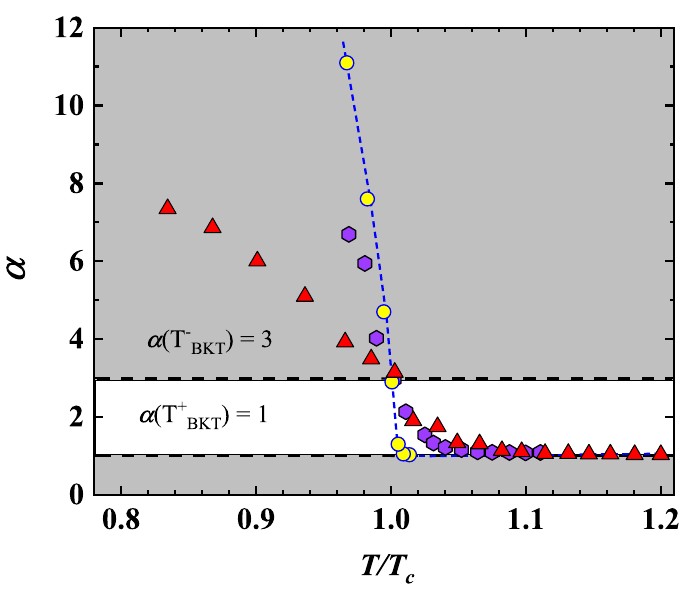
Figure 8. Temperature − dependence of α for MO10 (yellow circle), derived from the power-law fitting of the V-I curves plotted in the Figure 7. A jump in the value of α from (cid:39) 1 to (cid:39) 3 (white region) was detected at T BKT , corresponding to T / T c = 0.989. For comparison, the α values for a 3 nm thick NbN film from the work of Venditti et al. (purple hexagon) [16] and for Mo S 2 from the work of Saito et al. (red triangle) [50] were added to the data. The broken line is a guide for the eyes. The temperature was normalized to T BKT for our and Saito et al. data. Venditti et al.’s α values were derived by digitization of Figure (2e) in ref.